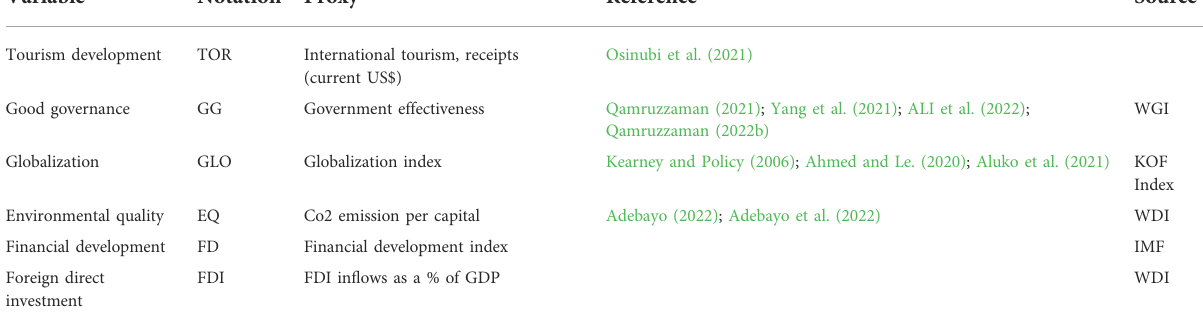
TABLE 1 Proxy measures of research